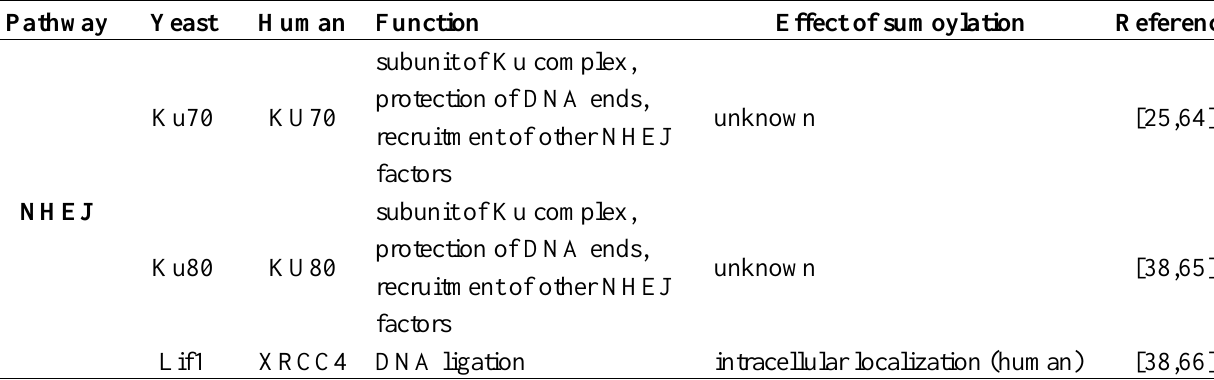
Table 1. Sumoylated proteins involved in DSB